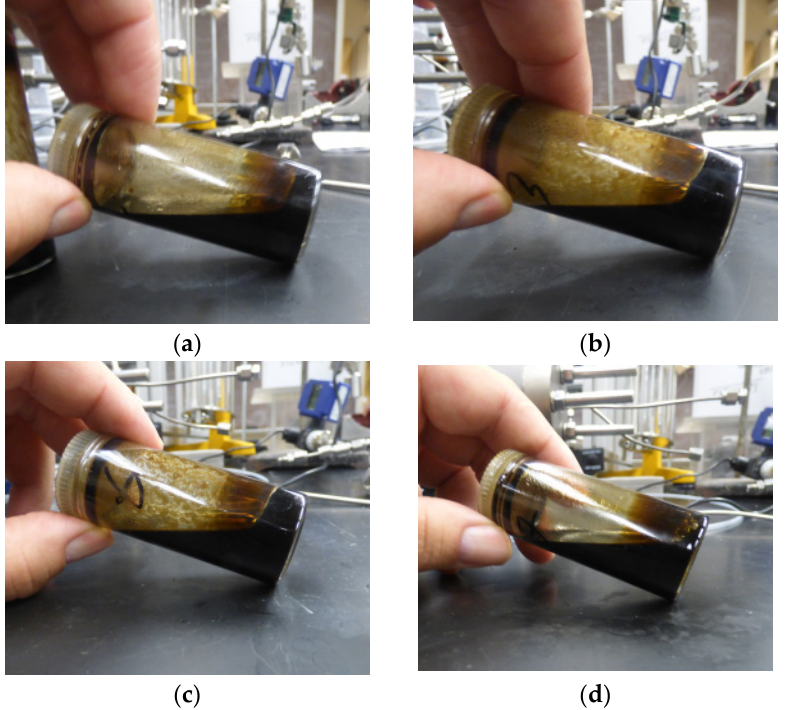
Figure 4. Images taken after 24 h of mixing, showing the presence of a thick emulsion (sludge) at the bottom of the vial for ( a ) de-emulsifier 1, ( b ) de-emulsifier 3, and ( c ) de-emulsifier 6, and the absence of a thick emulsion in ( d ) de-emulsifier 7.